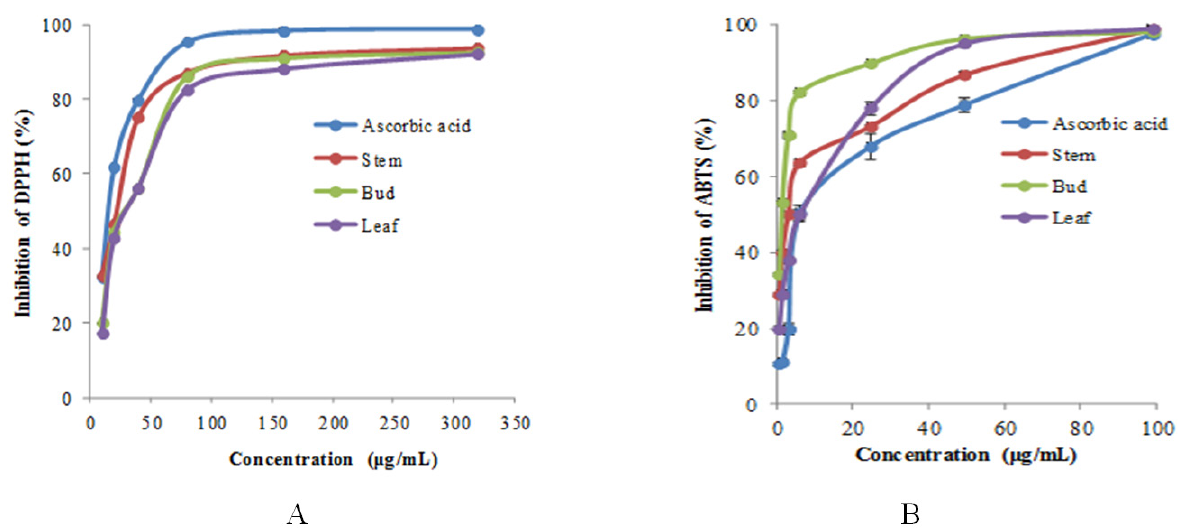
Figure 1 : Scavenging effect of different essential oils and ascorbic acid (A) DPPH, (B) ABTS assays at concentration 319.45 µg/mL and 99.00 µg/mL. Mean values are significantly average SD± n =3.